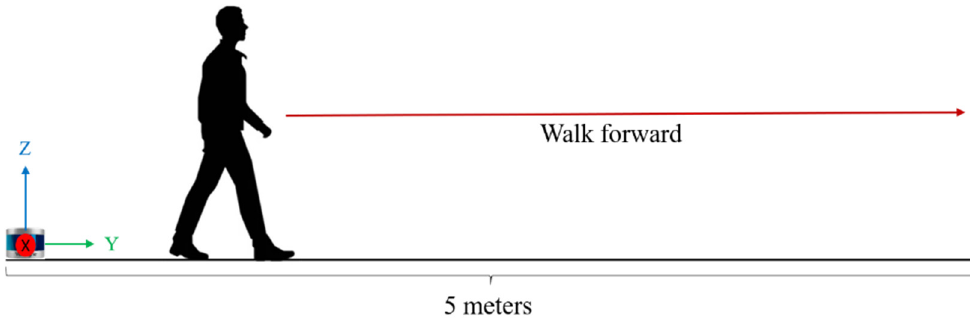
Figure 2. Walking experiment setup.